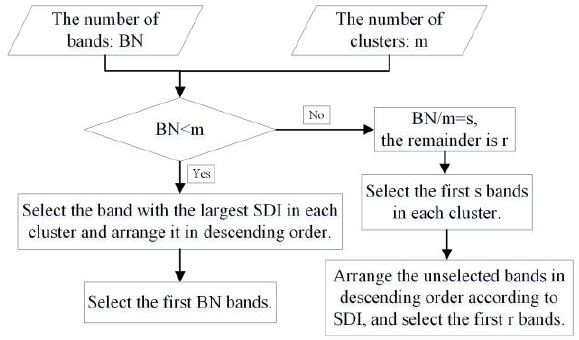
Figure 3. The band selection according to SDI in all